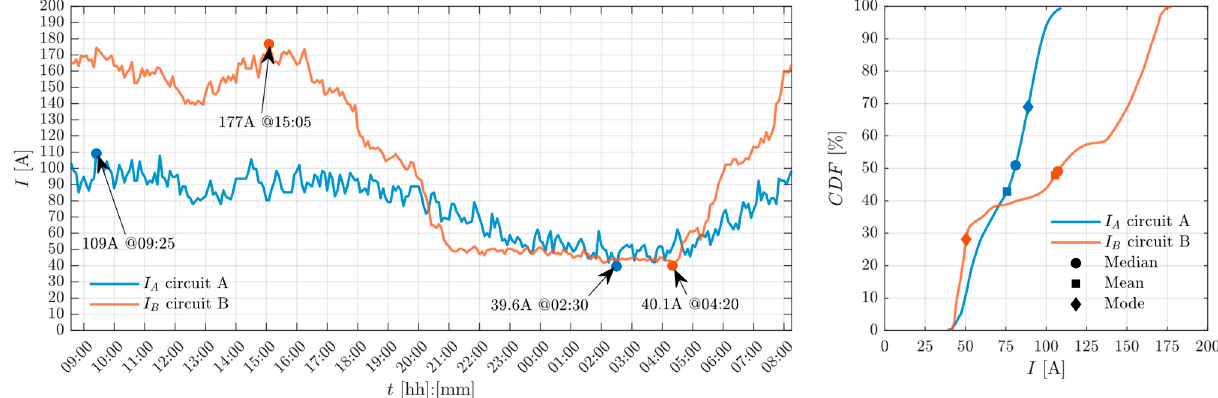
Figure 5. Instantaneous values of the currents over the 24 h ( left ) and its cumulative distribution function ( right ) in circuit A (blue trace) and circuit B (orange trace) starting from the 23rd of January.